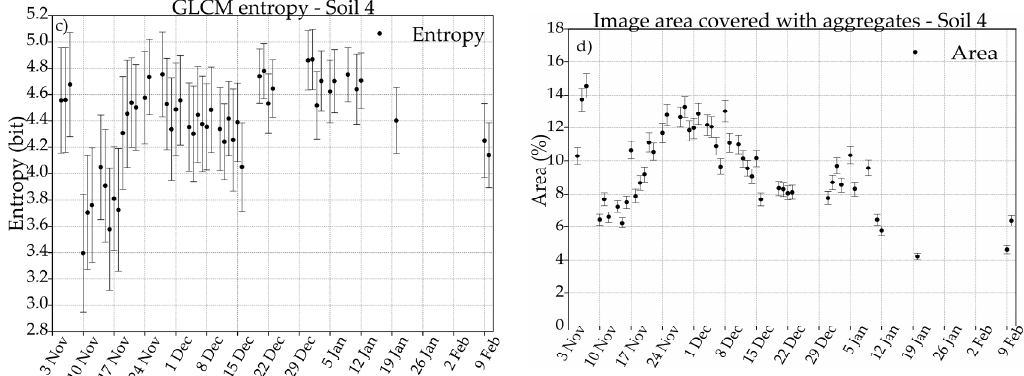
Figure 8. Weather data ( a ) together with shadow ratio ( b ), entropy ( c ); and area ( d ) results of Soil 4 are shown. Gray bars and gray line indicate daily rainfall and minimum air temperature, respectively. The gray dashed horizontal line indicates the temperature in °C. The vertical black dashed lines show missing rainfall data interval from 15 to 23 November 2014. The error bars indicate the standard deviation of: shadow ratio ( b ); and entropy ( c ). The standard error bars of area ( d ) represent the 95% confidence interval of the true population mean for the sample size 50.